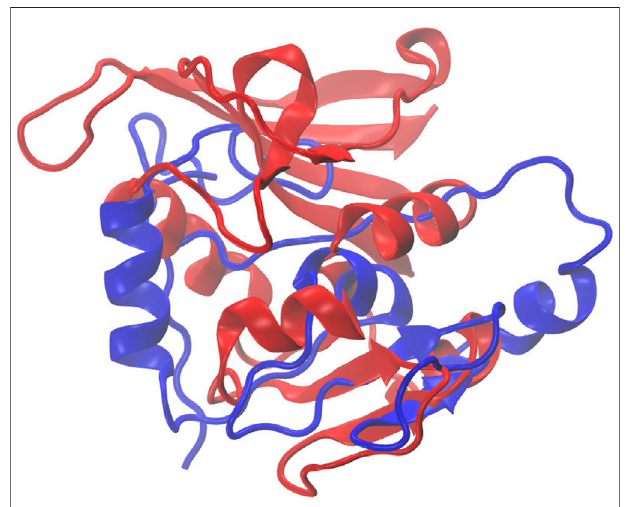
FIGURE 7 | Superposition of the structure of 1RX2 (red) over the structure determined by REDCRAFT (blue). The two structures exhibit 21 Å of bb-rmsd.